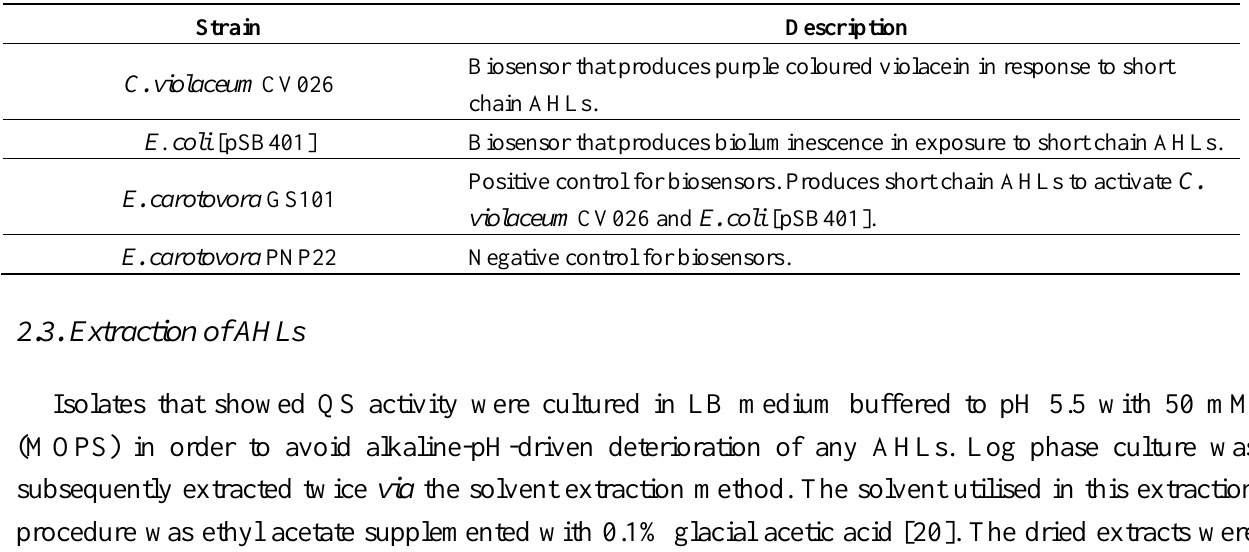
Table 1. Reporter strains and control strains used in this